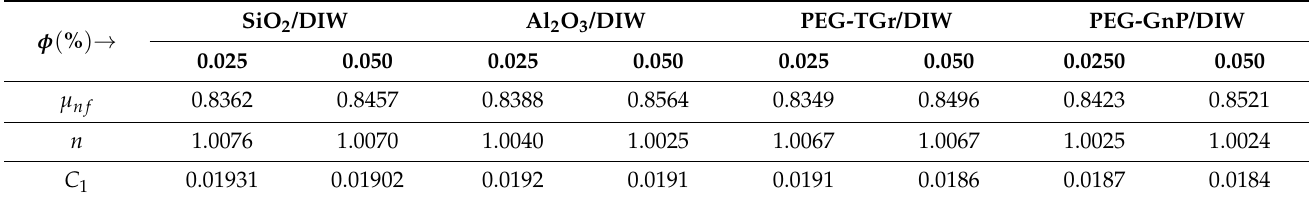
Table 1. The values of curve fitting parameters of Equation (2).